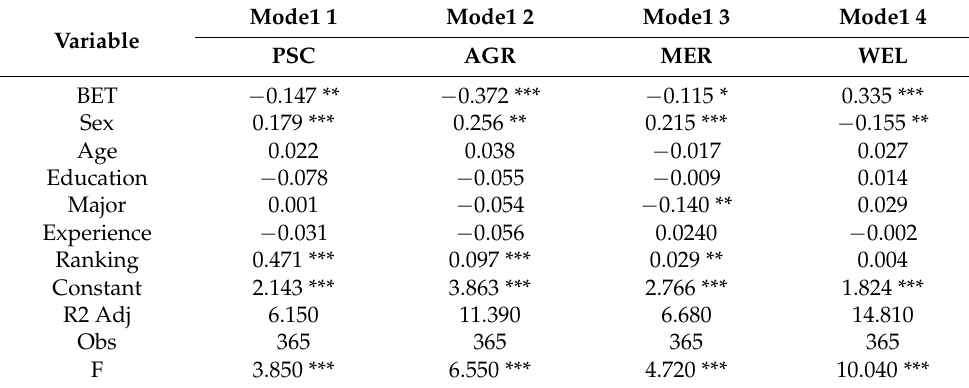
Table 10. Regression results of Iranian data.